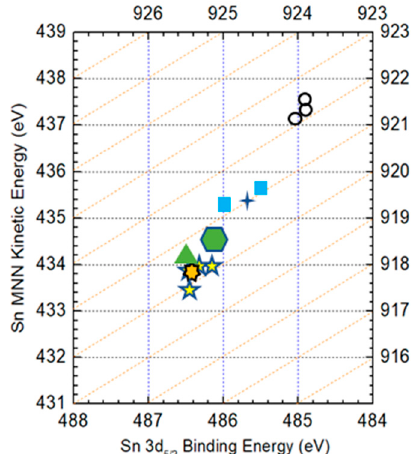
Figure 9. Auger parameters of Sn in Sn metal, CZTS and SnS compounds. The ( ), ( ), ( ) ( ) and ( ) symbols show the reference data of Sn metal, SnS, Sn 2 S 3 , SnS 2 and CZTS in a CZTS film, respectively. The ( ) symbol shows experimental data on the surface in this work. ( ) shows experimental data in the bulk of a CZTS film.